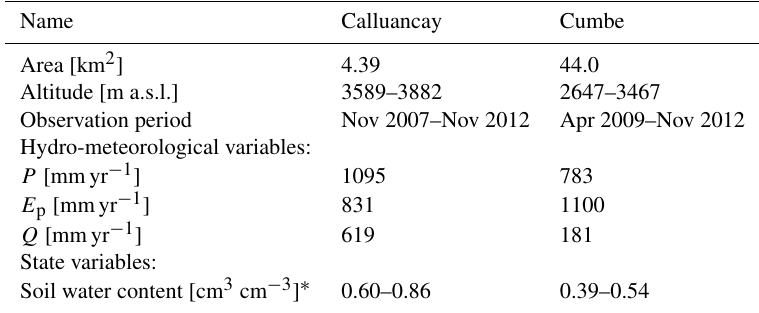
Table 1. The main characteristics of the experimental catchments.